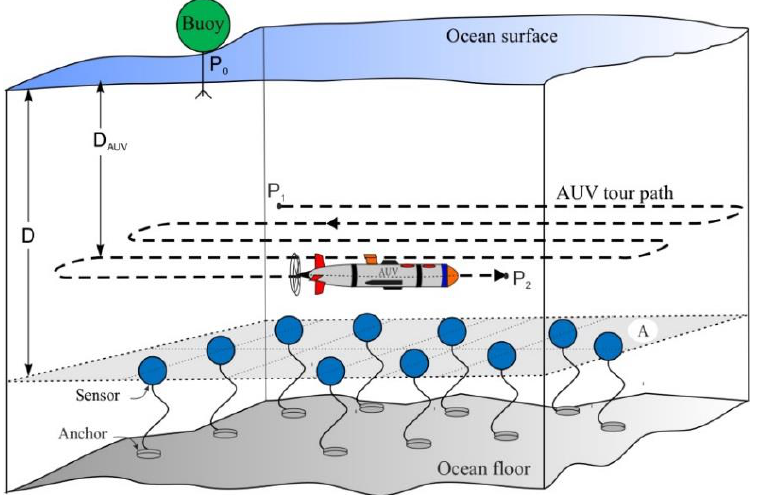
Figure 1. Network